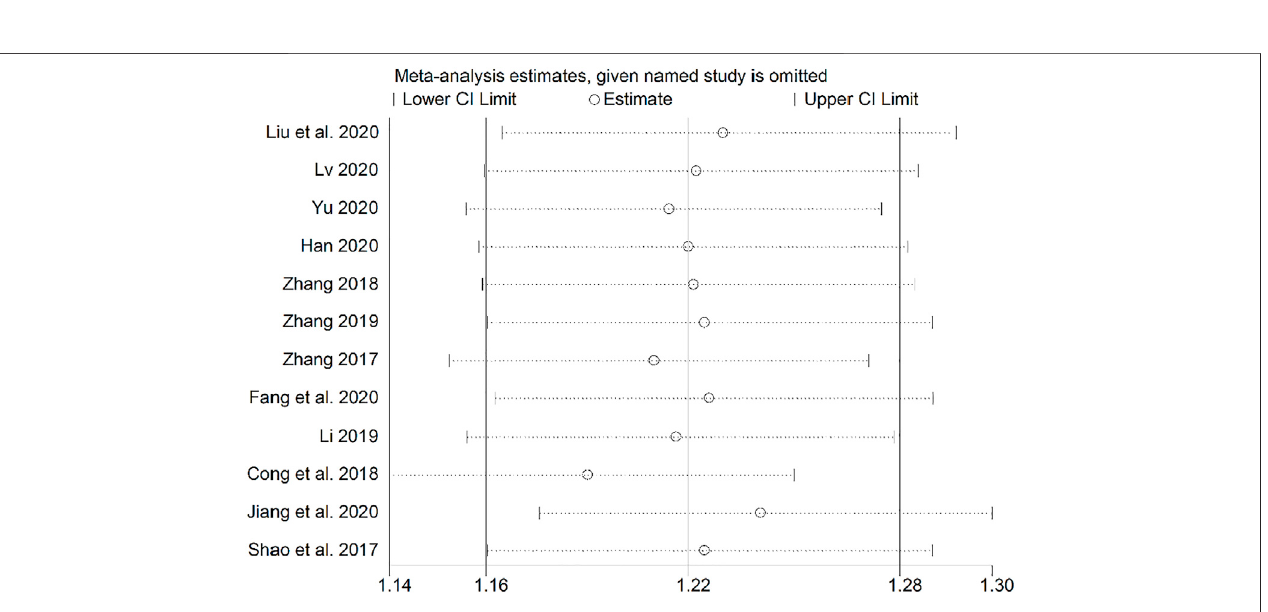
FIGURE 14 | Sensitivity analysis.